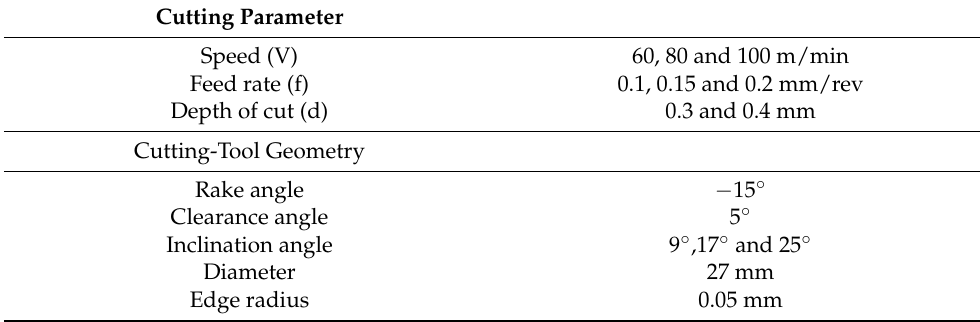
Figure 1. Turning experiment setup with SPRT. Table 1. Variables of cutting and tool geometry for experiments and finite element (FE) models.